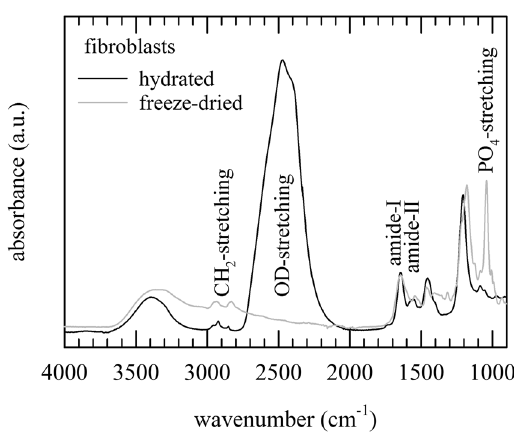
Figure 2. In situ infrared spectra of fibroblasts; both, ATR-FTIR spectra of freeze-dried samples without protectants (grey line) and hydrated samples in saline/D 2 O (black line) are shown. The full spectral region (4000–900 cm − 1 ) is presented, with indicated absorbance bands arising from endogenous membrane lipids (CH 2 -streching bands, 3000–2800 cm − 1 ), proteins (amide-I and -II bands, 1700–1500 cm − 1 ), and (nuclear) DNA (PO 4 -streching bands, 1300–1000 cm − 1 ). The OD-stretching band arising from D 2 O is located between 2700–2200 cm − 1